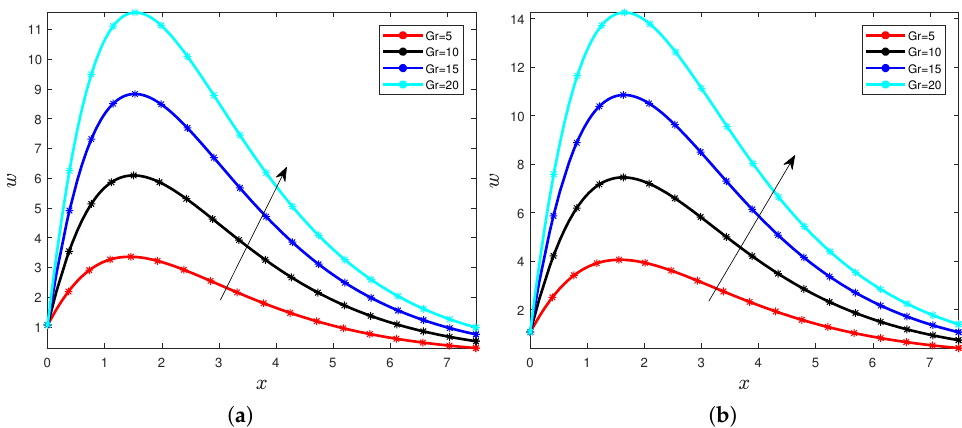
Figure 4. Velocity for different values of the order α = 0.65 ( a ) and α = 0.75 ( b ).